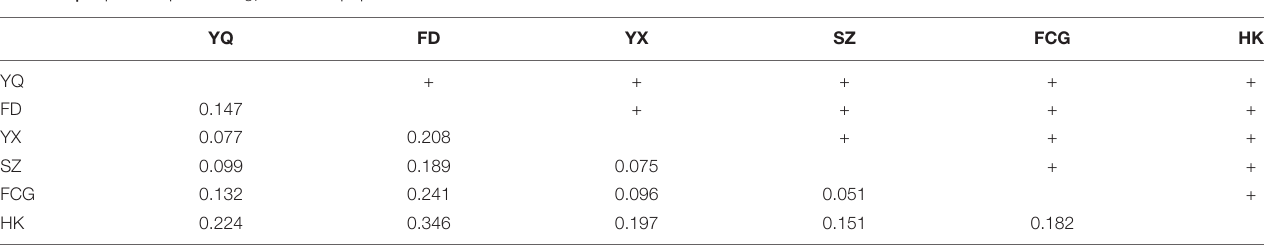
TABLE 4 | Population pairwise F ST of the six populations of K. obovata .